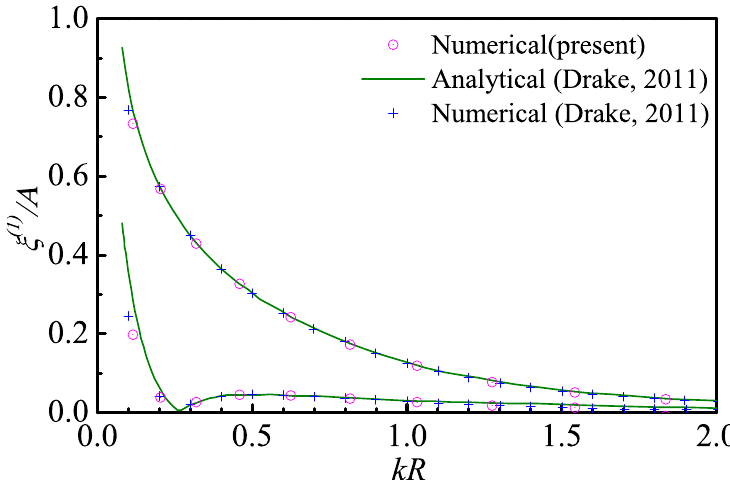
Figure 7. Lateral displacement of spar at still waterline and the base: upper line and symbols for still waterline; lower line and symbols for the base.